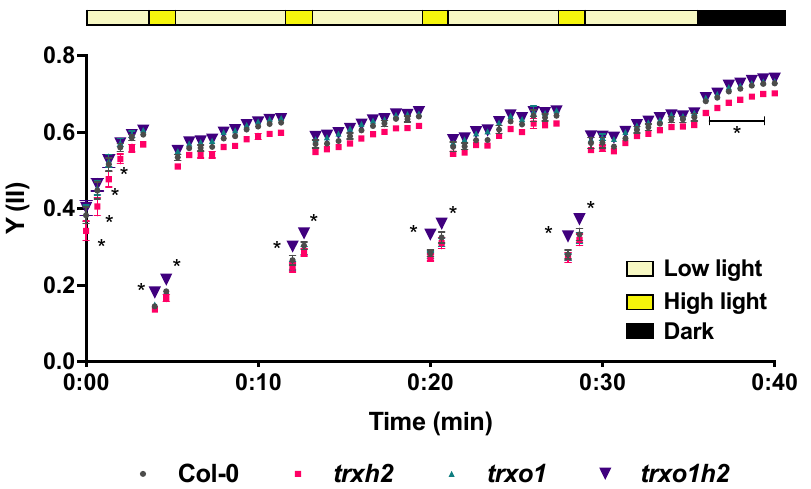
Figure 8. The quantum yield of photosystem II (Y(II)) in the wild type (Col-0) and the mutant lines ( trxh2 , trxo1 and trxo1h2 ) in fluctuating light. Arabidopsis plants were grown in a fluctuating light environment for four weeks. Chlorophyll fluorescence kinetics during the alternating periods of low light (5 min) and high light (1 min) were recorded by using a PAM system, and the values were used for calculating Y(II). Mean values and standard errors derived from 6 biological replicates. The statistical analyses were performed using ANOVA and the Dunnett’s test (* p < 0.05, in comparison to the wild type).